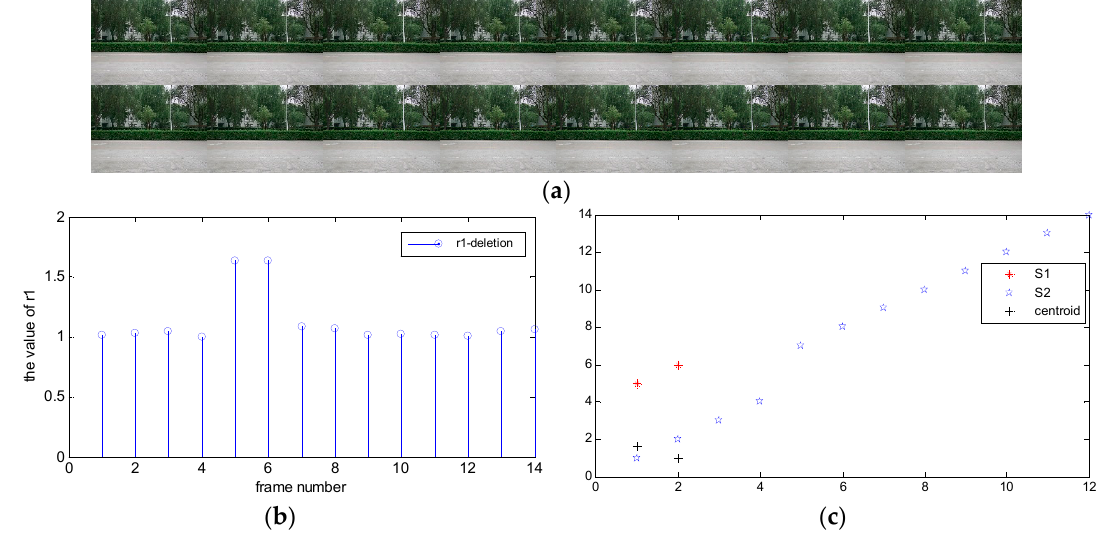
Figure 9. Frame deletion and clustering results. ( a ) Sixteen frames from a video tampered by frame deletion; ( b ) The curve of ∆r1 ; ( c ) clustering results.